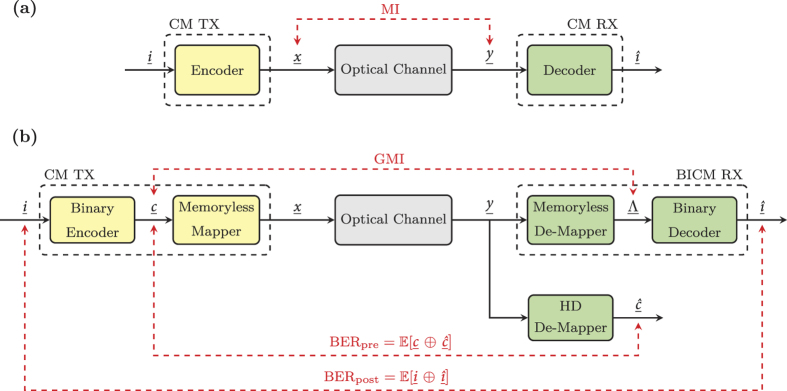
Coded modulation.(a) CM system using the optimal ML decoder. The MI is estimated using the transmitted and received symbols. (b) BICM system illustrating the variables used to measure the GMI, BERpre and BERpost.